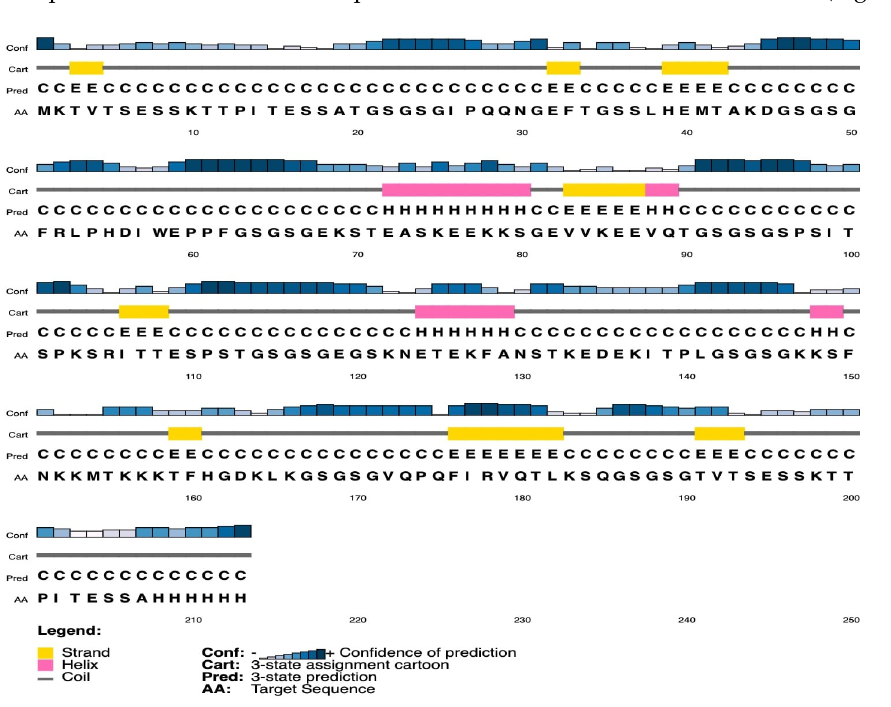
Figure 1. Schematic representation of OvMCBL02 multiepitope antigen with methionine coupled at the N-terminus and 6X His tag to its C-terminus. The various linear B-epitopes (LBE) are repre- sented with different colors.